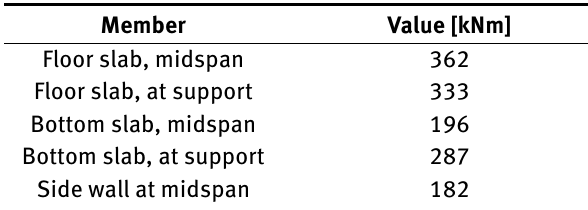
Table 6: Bending moment values used for bridge